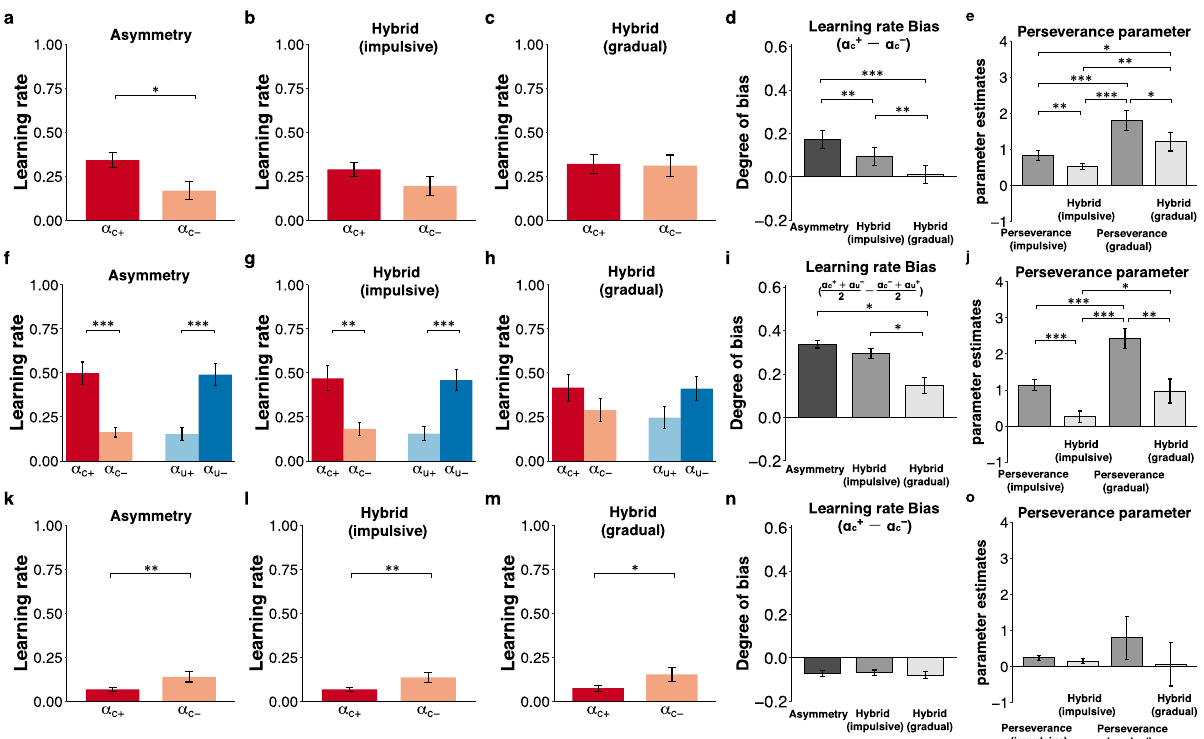
Figure 5. The results of open datasets 1 and 2. ( a – e ) The results of open dataset 1 (Palminteri et al.) in the factual learning context. ( f – j ) The results of open dataset 1 in the counterfactual learning context. ( k – o ) The results of open dataset 2 (Niv et al. 2012). The first to third columns indicate the learning rates ( α + c and α − c in the factual learning context; α + c , α − c , α + u , and α − u in the counterfactual context) in the Asymmetry ( a , f , k ), Hybrid (impulsive) ( b , g , l ), and Hybrid (gradual) ( c , h , m ) models. ( d , i , n ) The fourth column shows the degree of learning rate bias. ( e , j , o ) The final column shows the perseverance parameter ( φ ) in the Perseverance (impulsive), Perseverance (gradual), Hybrid (impulsive), and Hybrid (gradual) models. *** p < 0.001, ** p < 0.01 and * p < 0.05. The error bars represent the standard error of the